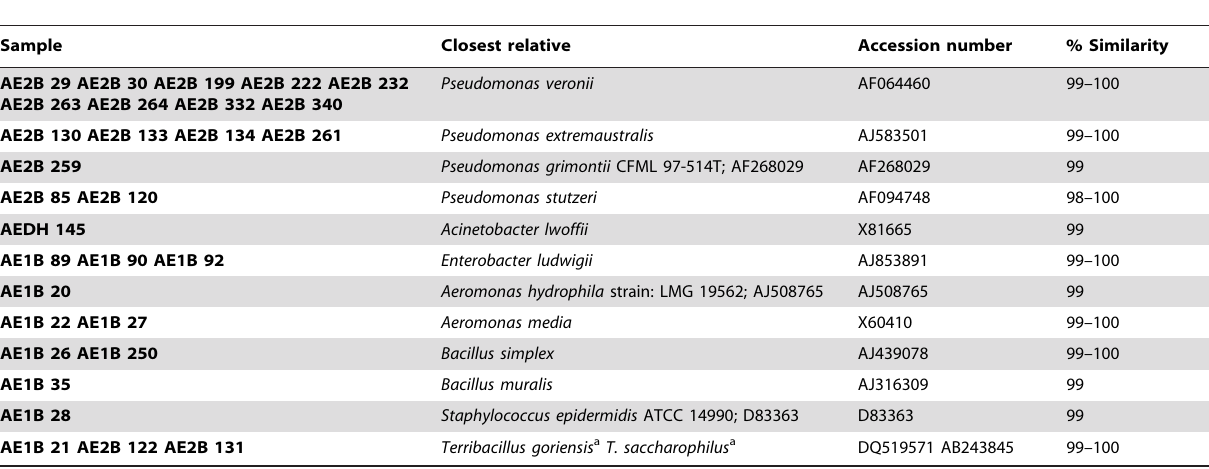
Table 5. The closest relative of each isolate is indicated based on the phylogenetic reconstruction shown in Figure 3.